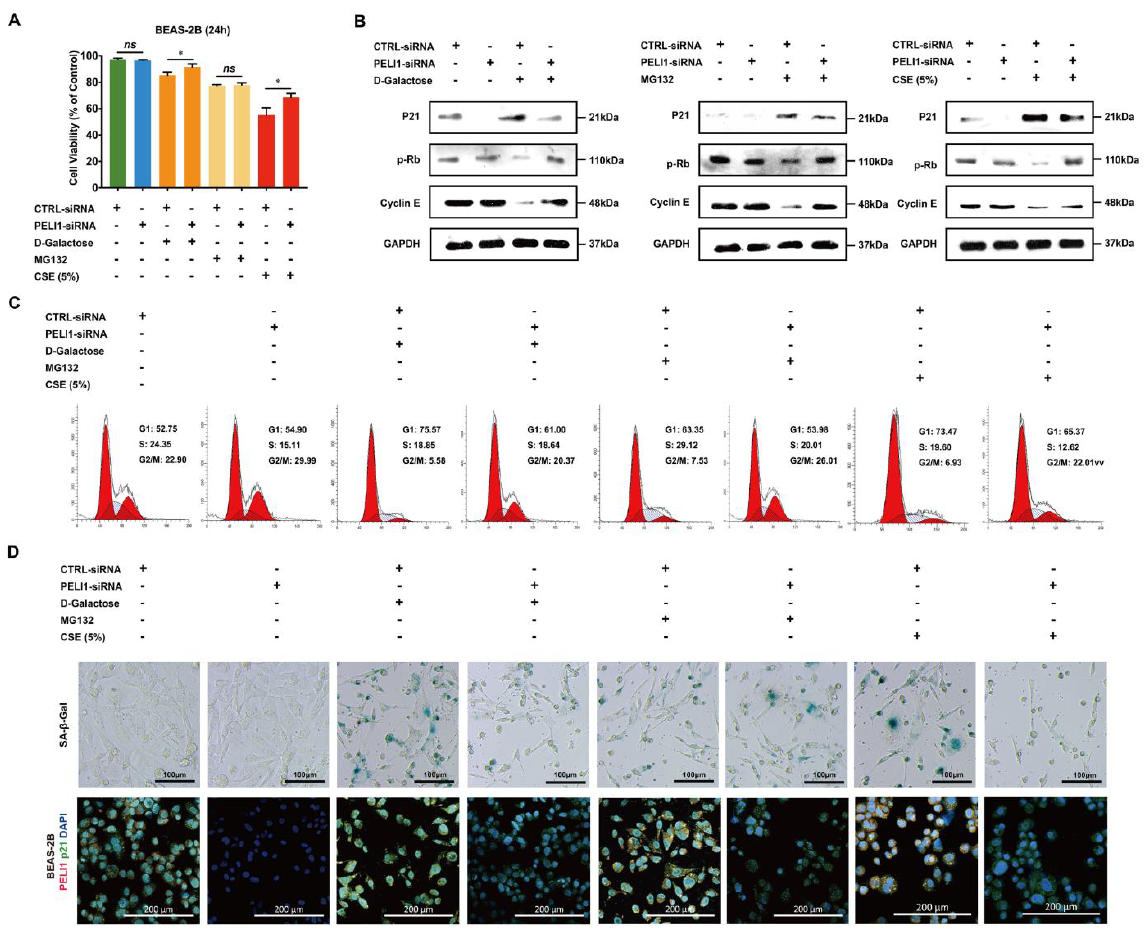
Figure 2. Silencing Pellino-1 inhibits G1 \ S arrest and cellular senescence caused by CSE and D- Galactose. ( A ) Treatment with CSE (5%) or D-Galactose (20 µ g/mL) led to a decrease in the cell viability of BEAS-2B cells, which could be relieved by silencing PELI1. Data represent mean ± SEM; * p < 0.05, ns for not significant (n = 4). ( B ) CSE or D-Galactose treatment led to an increase in p21 and a decrease in p-Rb and Cyclin E, which could be relieved by silencing PELI1. Silencing PELI1 did not change the p21 level but did alter p-Rb and Cyclin E levels in cells treated with MG132 (n = 3). ( C ) The cell cycle of BEAS-2B showed G1 phase arrest following treatment with CSE and D-Galactose. Silencing PELI1 could help cells step into S phase (n = 3). ( D ) Up: SA- β -galactose staining showed that CSE, MG132, or D-Galactose treatment led to the cellular senescence of BEAS-2B. Such senescence could be inhibited by silencing PELI1 (n = 4). Down: Immunofluorescence staining assay showed that silencing PELI1 reduced the overexpressed p21 level caused by CSE or D-Galactose treatment. MG132 treatment did not produce the same